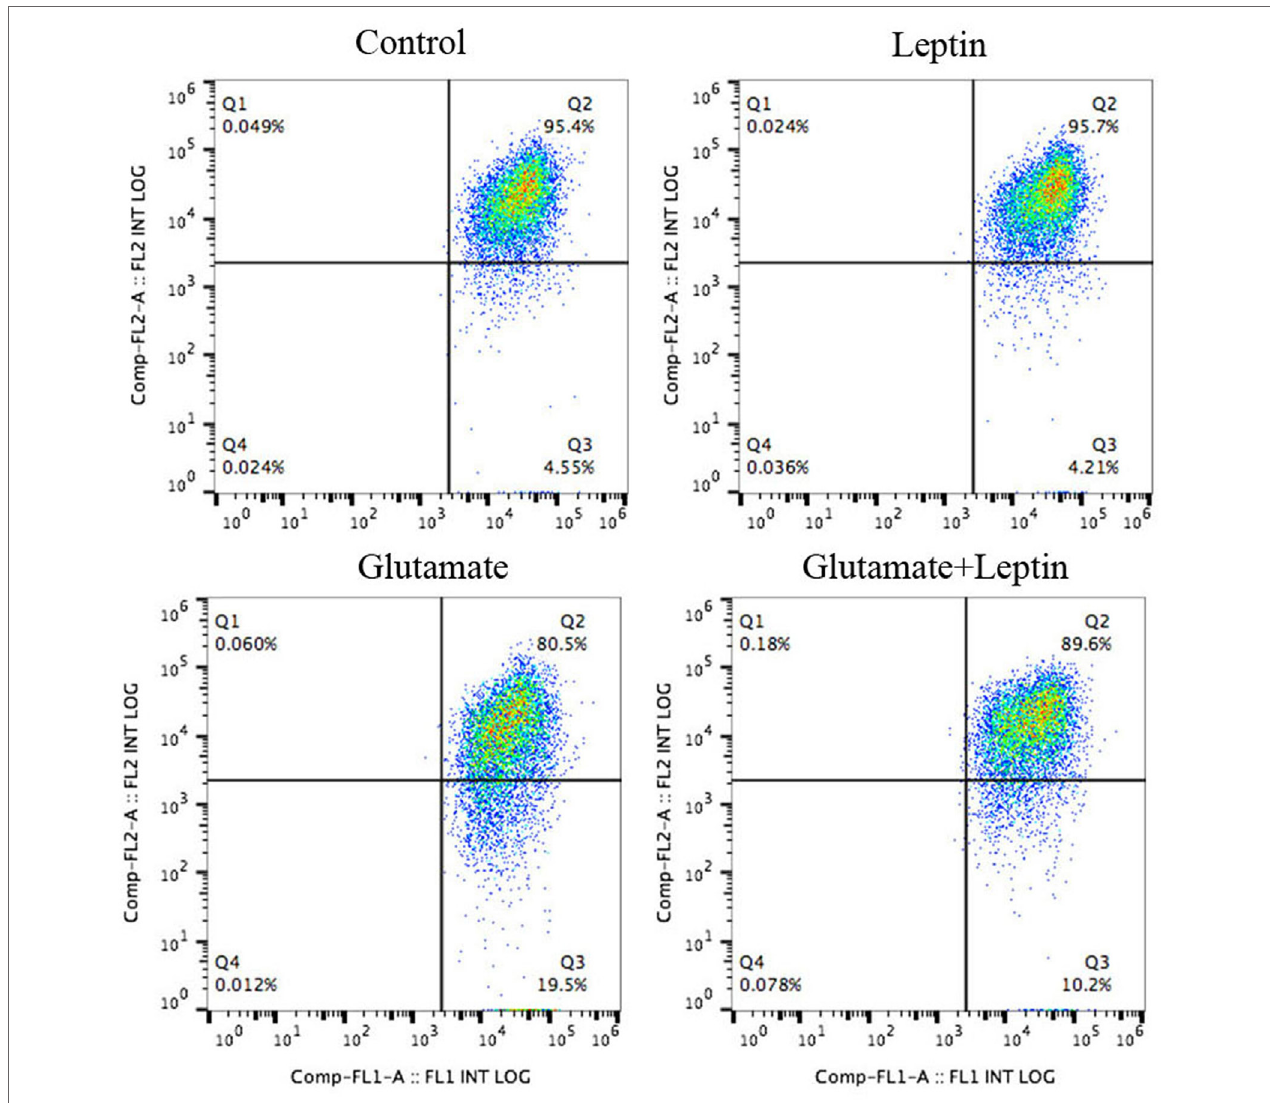
FigUre 3 | Leptin preserves glutamate-induced mitochondrial membrane